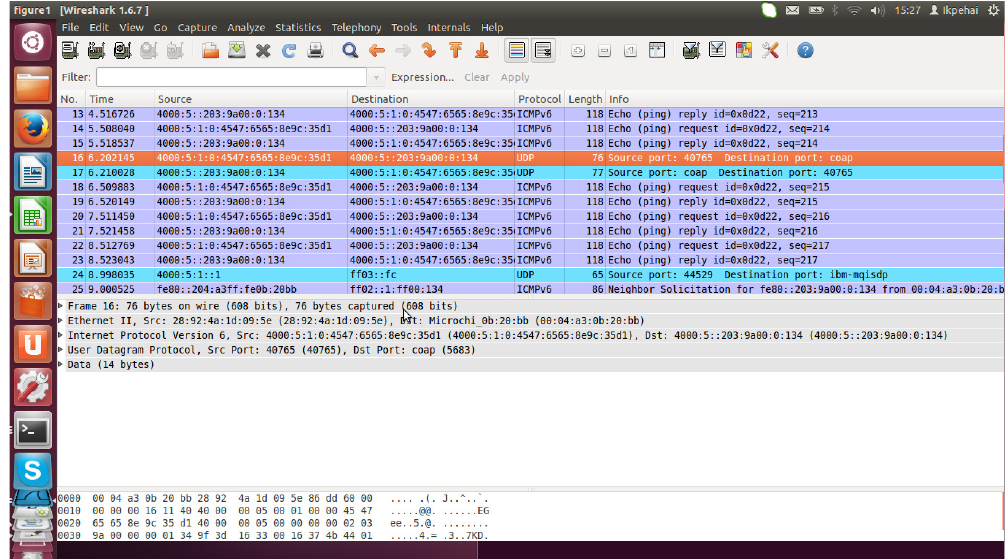
Figure 5. Traffic capture in Wireshark showing the packet